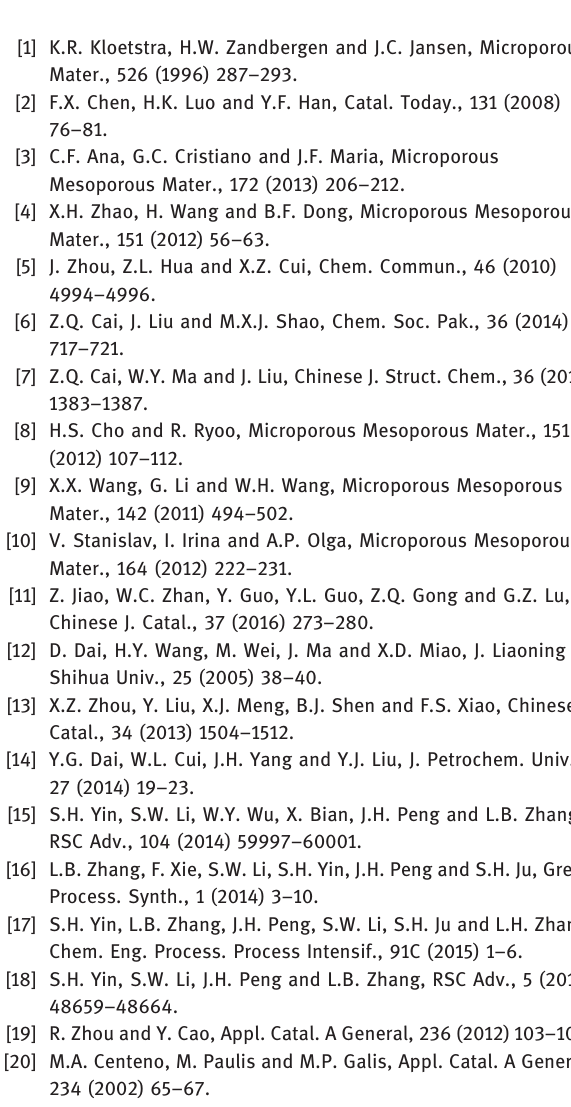
of Ce doped on composite molecular sieves which applied to the hydrocracking of heavy oil.